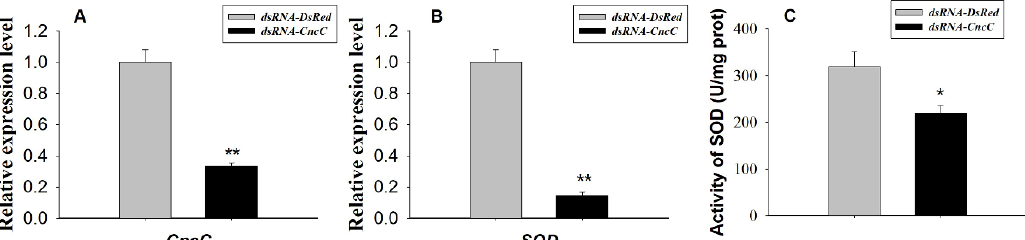
8 of 12 Figure 4. Over-expression analyses of Sf CncC regulate SOD gene transcription in Sf9 cells. The mRNA transcription level (means±SD) of SOD in Sf9 cells transfected with pAC- Sf CncC construct and pAC vector. The error bars indicate 95% confidence intervals (n = 3). ** indicated significant difference by Student's t-text ( p < 0.01). 3.4. RNAi Analysis of SfCncC Regulating SOD in Sf9 Cell and Larvae The Sf9 cells and larvae transfected/injected with dsRNA (Cnc dsRNA or DsRed dsRNA) were harvested after 96 h or 72 h for total RNA extraction and cDNA synthesis, respectively. Results demonstrated that the knock down of Sf CncC leads the significant down-regulated SOD transcription in Sf9 cells (Figure 5). The mRNA transcription level of Sf CncC from the Sf9 cells treated with dsRNA- CncC was 2.98-fold less ( p < 0.01) than cells treated with dsRNA- DsRed (Figure 5A). The transcription